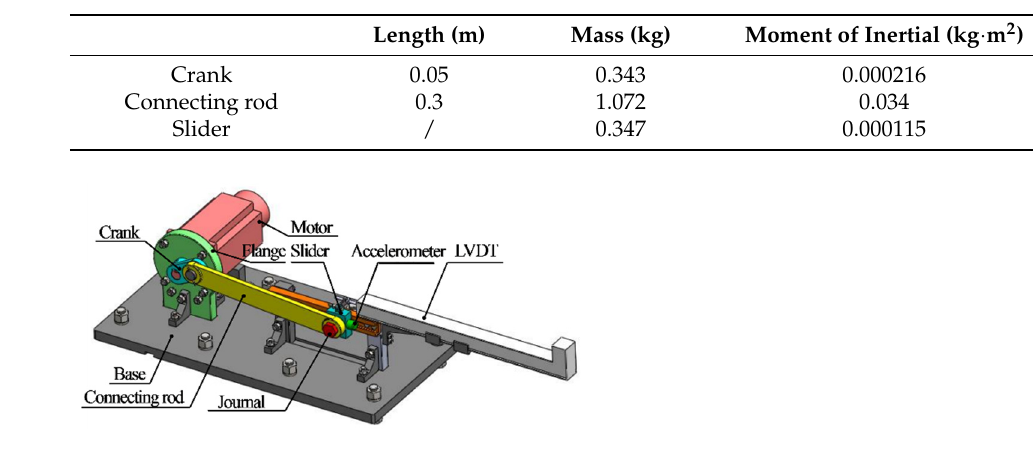
Table 3. Mechanism parameters [29].